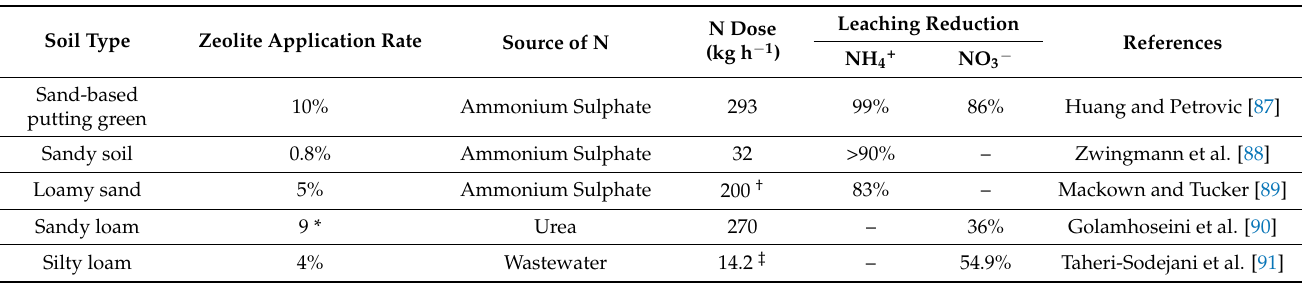
Table 3. Leaching Reduction Percent of NH 4+ and NO 3 − from Different Nitrogenous Fertilizer with the Application of